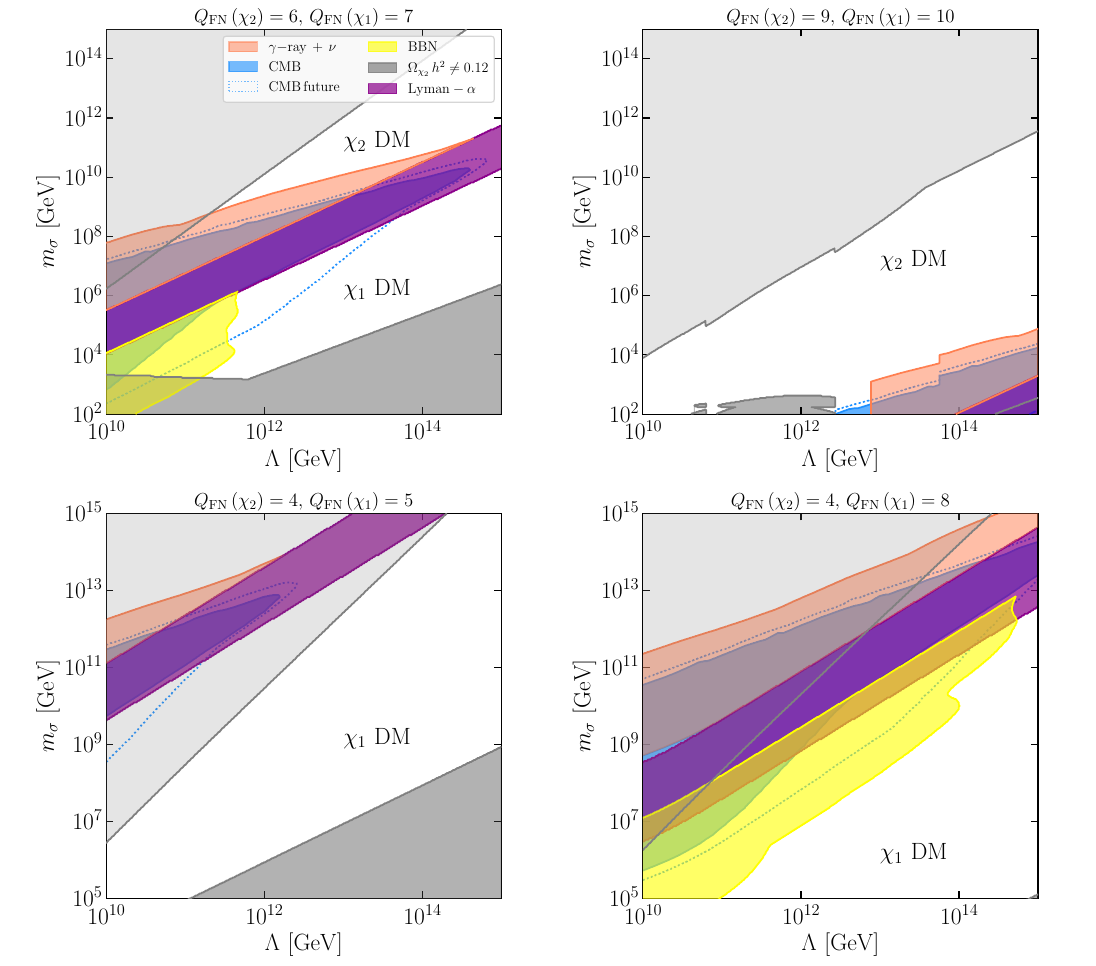
Figure 4 . Parameter space for two-component flavon dark matter for a number of charge config- urations. Shaded regions show constrained or not viable regions. The grey regions outline where the correct relic abundance is not achievable for any T R between 10 2 GeV and T dec . Constraints for decaying dark matter into visible signals are marked by coral, yellow and blue, for γ -ray and neutrino searches, BBN and measurements of the CMB respectively. Warm DM constraints from Lyman- α is shown in purple. Future probes of the CMB are projected with a blue dotted line. The white region is viable for a consistent description of dark matter. We have denoted on each panel which fermion, χ 1 or χ 2 is the dominant dark matter